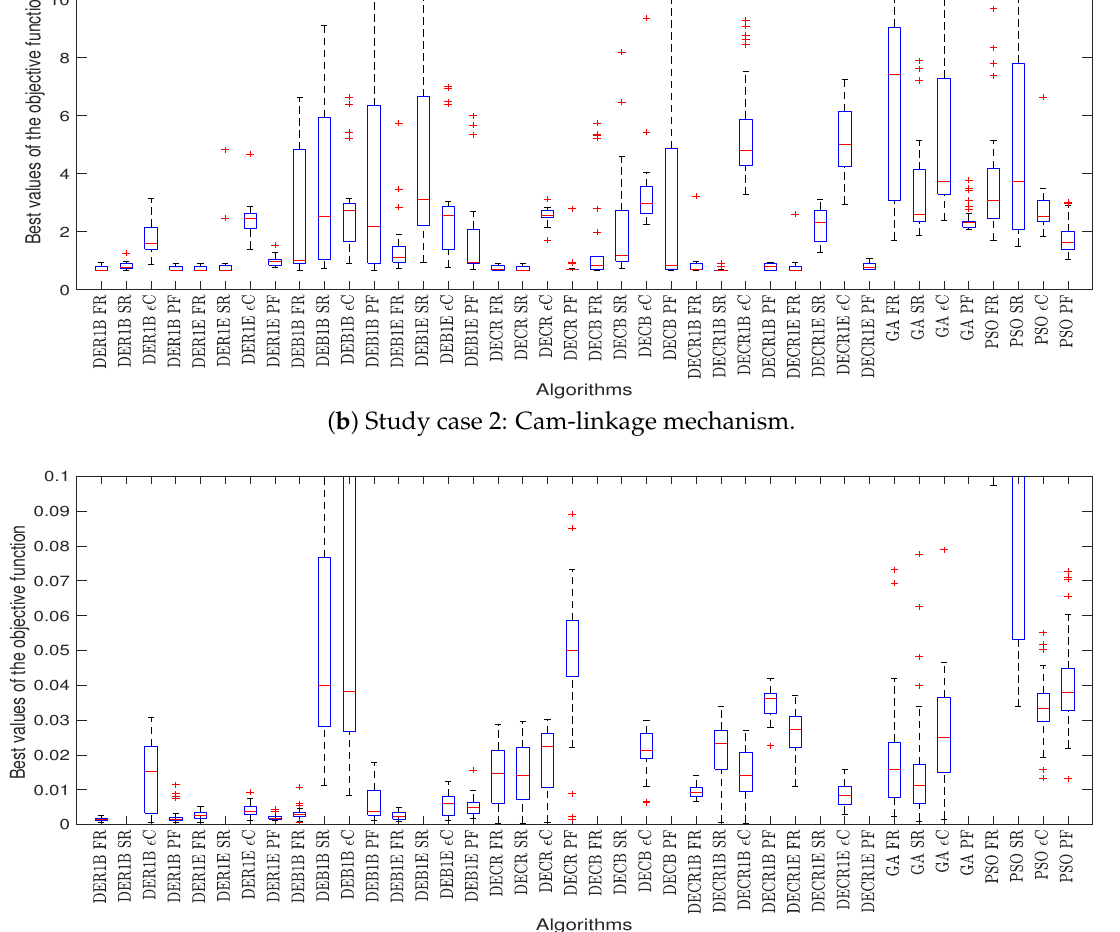
( c ) Study case 3: Eight-bar linkage mechanism. Figure 5. Box plot of the sample distribution obtained by the overall performance of the CHTs in ten metaheuristics at each study case of mechanism synthesis for lower limb